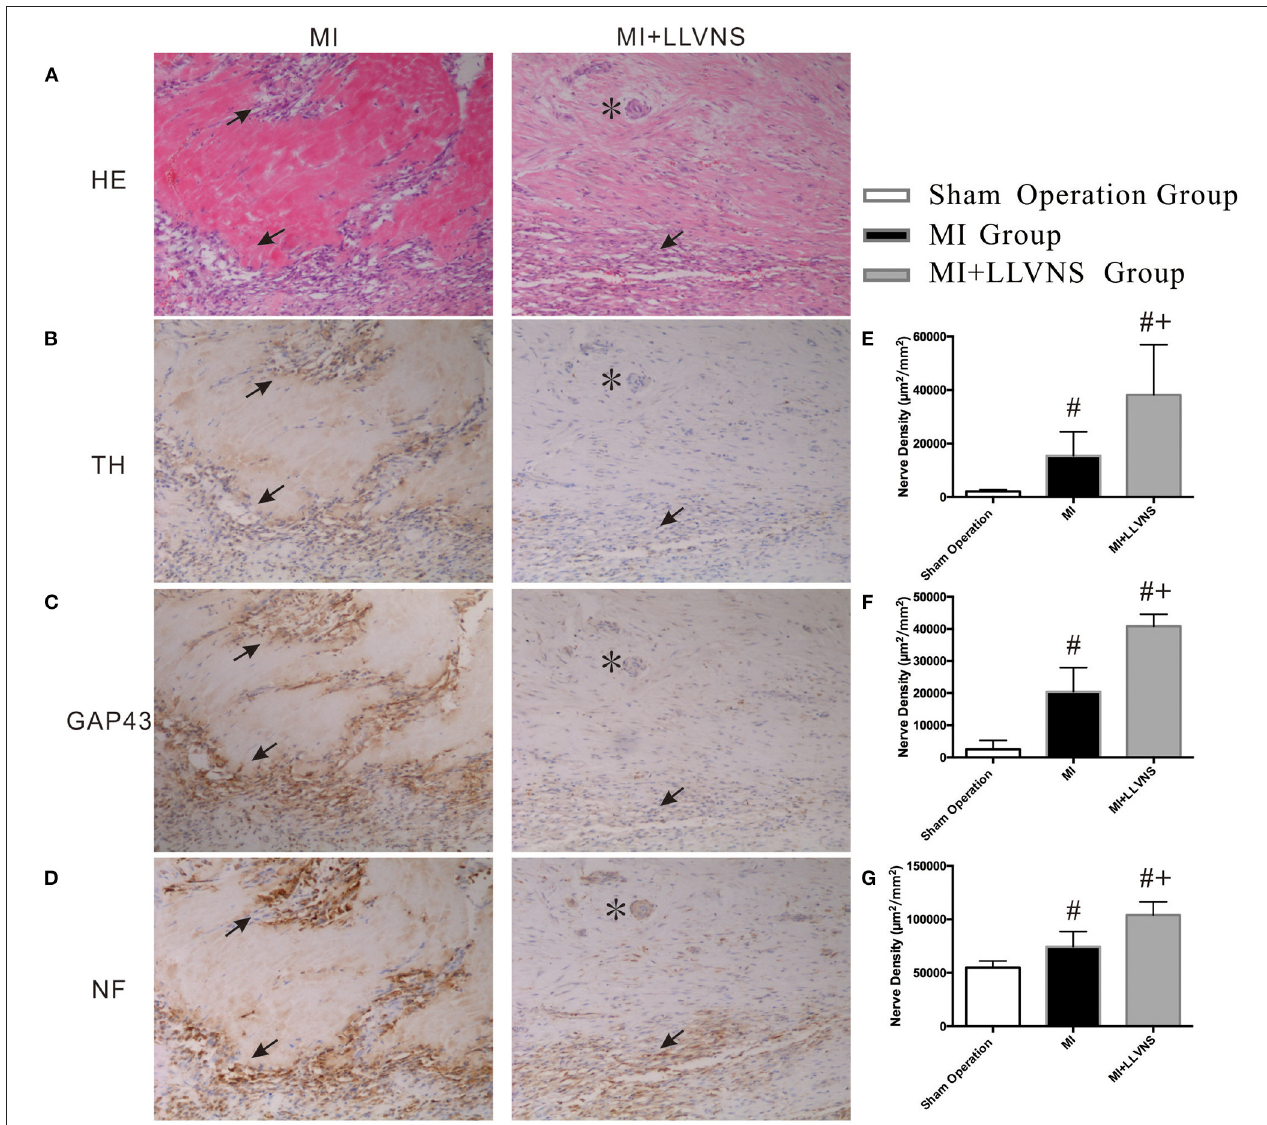
FIGURE 3 | Typical examples and densities of of TH-, GAP43- and NF-positive nerve fibers. (A) Border of myocardial injury was stained with hematoxylin and eosin (HE) as revealed by infiltration of inflammatory cells. (B–D) : Increased density of TH-, GAP 43- and NF-positive nerve fibers at the border of myocardial injury, respectively. (E–G) : Densities of TH-, GAP43- and NF-positive nerve fibers in three groups. The asterisk (*) indicates an artery in the cardiac tissue. Arrows in (A) indicate infiltration of inflammatory cells. Arrows in (B–D) indicate of TH-, GAP 43- and NF-positive nerve fibers separately. # compared with those in the sham operation, p < 0.05. + compared with those in MI group p < 0.05. TH, tyrosine hydroxylase; GAP43, growth associated protein 43; NF, neurofilament; LLVNS, low level left vagus nerve stimulation; MI, myocardial infarction. MI group ( n = 6), MI + LLVNS group ( n = 5), Sham operation group ( n =